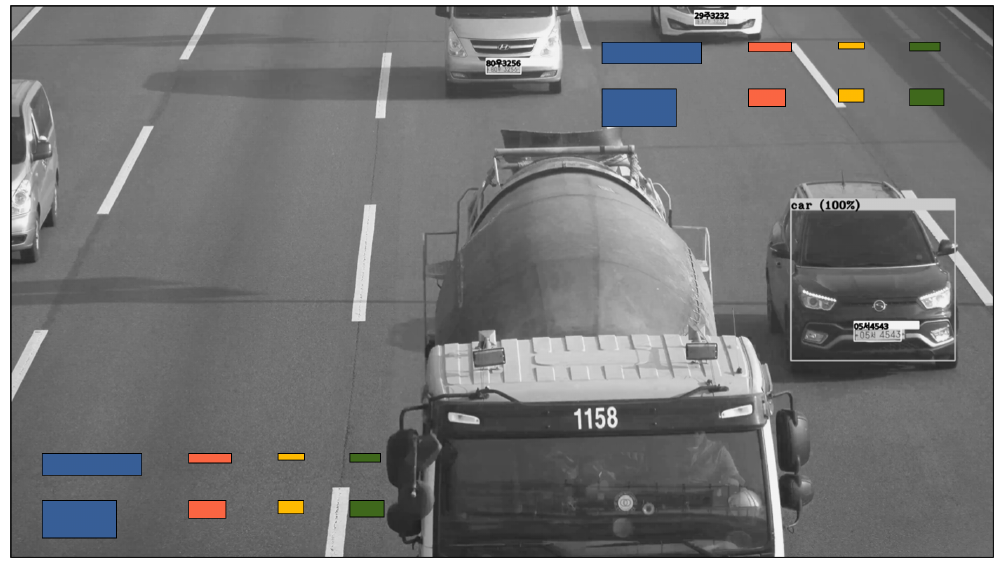
Figure 11. License plate sizes in one-lane , two-lane , three-lane , and four-lane images, repre- sented to scale on 3840 × 2160